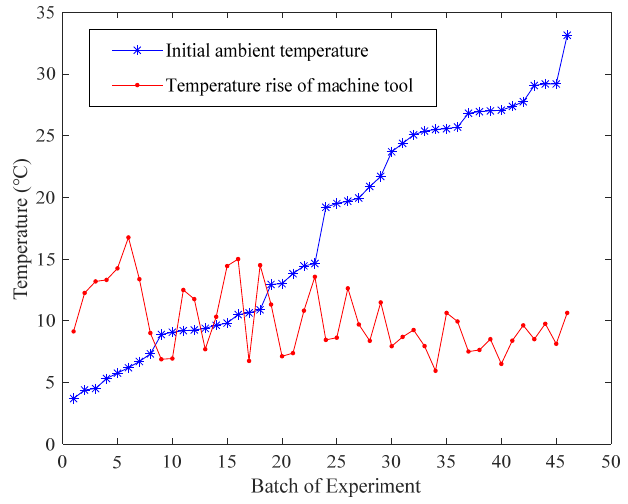
Figure 5. Statistical results of temperature changes of 46 batches of experiments.